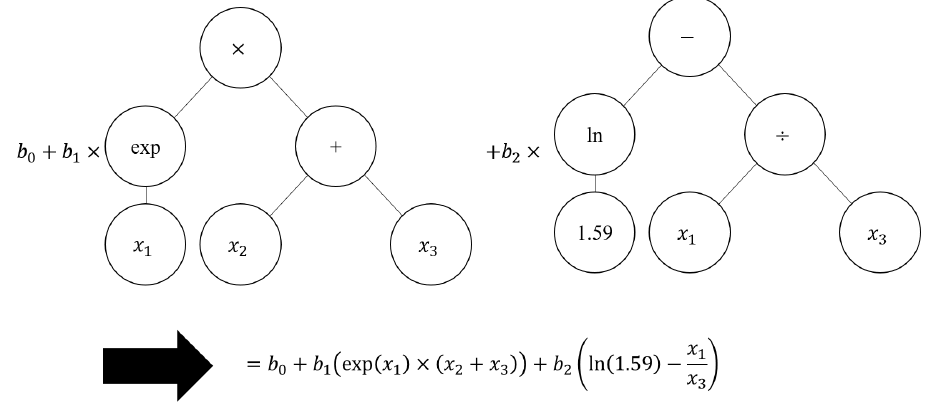
Figure 6. Example of MGGP tree